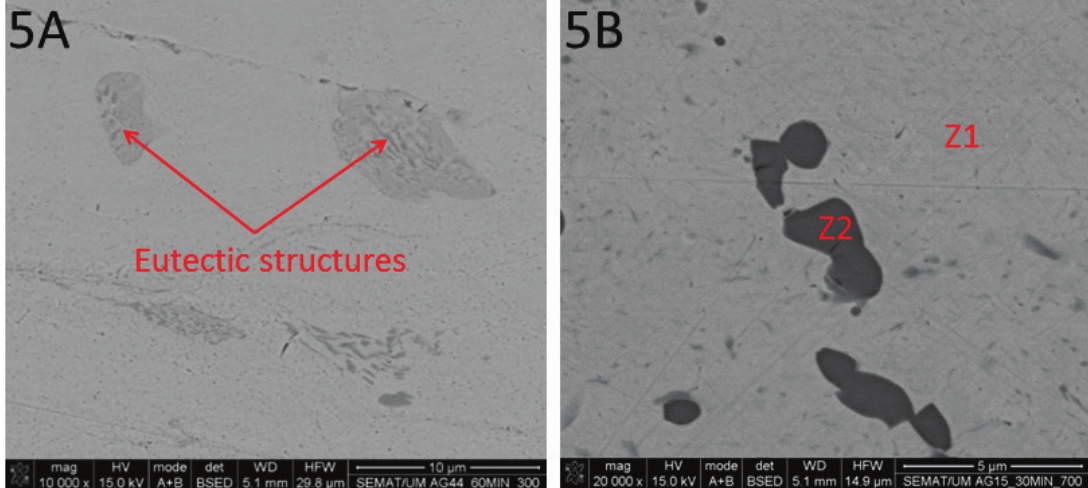
Figure 5. Micrographs of the hot pressed sterling silver compacts. A) 300 °C, 60min, 35MPa; B) 700 °C, 30min, 35MPa. The dark phase refers to a Cu-rich phase ( β